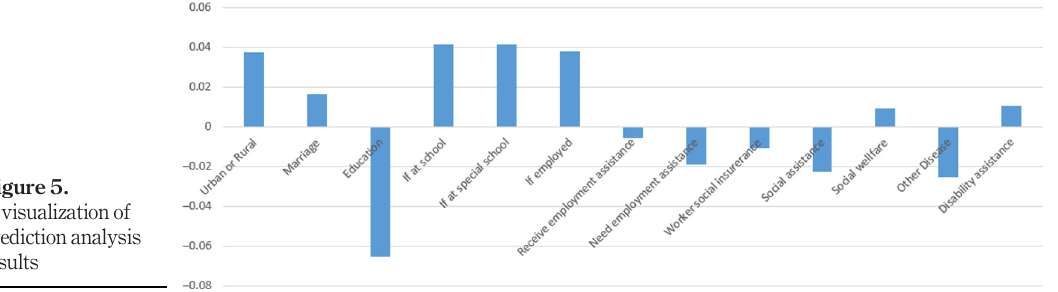
Figure 5. A visualization of prediction